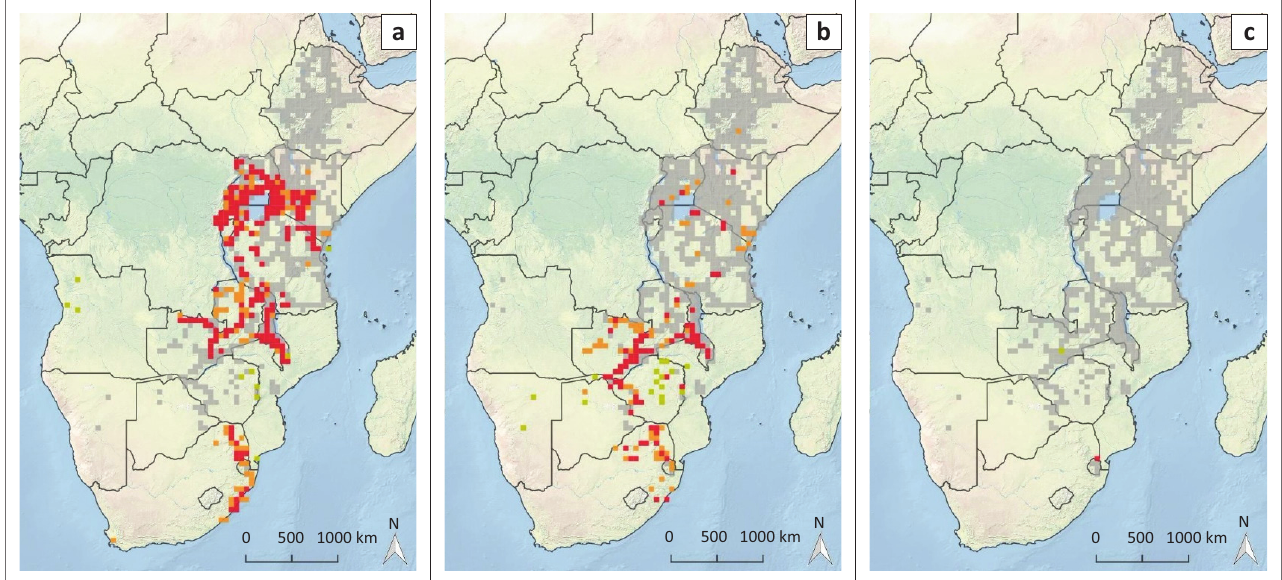
FIGURE 2: Maps showing the current known distribution of Tithonia diversifolia (a); T. rotundifolia (b); and T. tubaeformis (c) in eastern and southern Africa (55 km × 55 km/half degree grid cells) using data collected in this study and other sources of information. Grey grid cells show areas surveyed; red grid cells indicate areas where the Tithonia species were found to be invasive (widespread and/or abundant); orange cells where they were present and/or naturalised; and yellow cells where they were recorded with no other information.